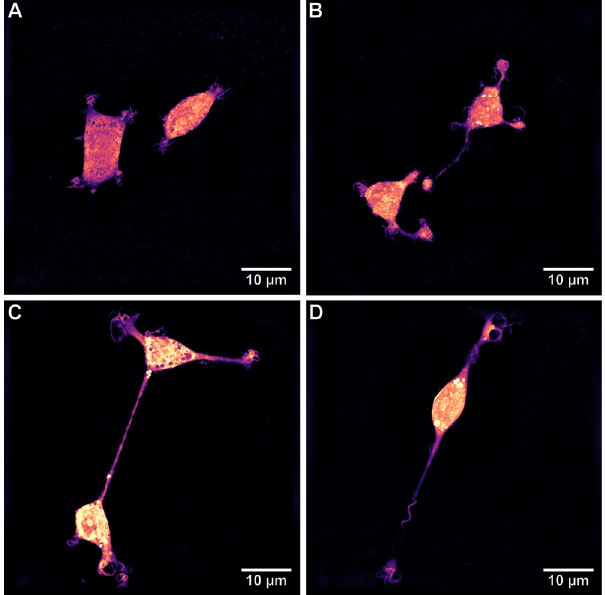
Figure 8. The representative microphotograph of a non-differentiated PC12 cells ( A ); the representative microphotographs of PC12 cells differentiated into neuron-like cells: after 2 days ( B ), after 4 days ( C ), and after 5 days ( D ) of incubation with human NGF- β . The morphological changes during the differentiation process were analyzed with the 3D Cell Explorer free-label microscope.